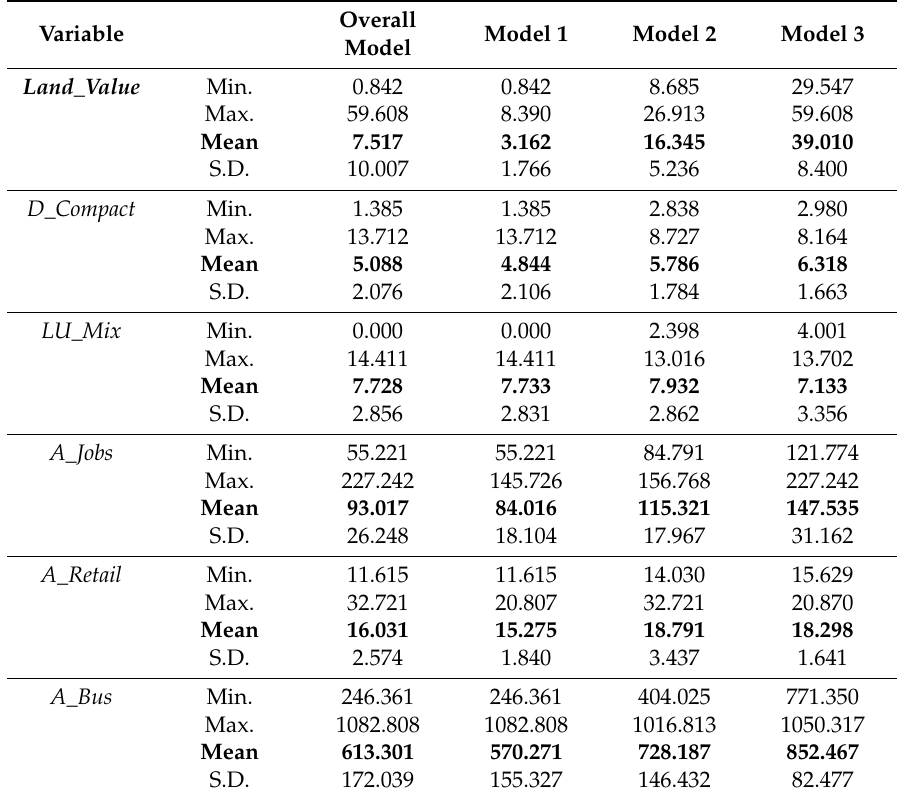
Table 8. Descriptive statistics of the overall and three sub-group models—minimum, maximum, mean, and standard